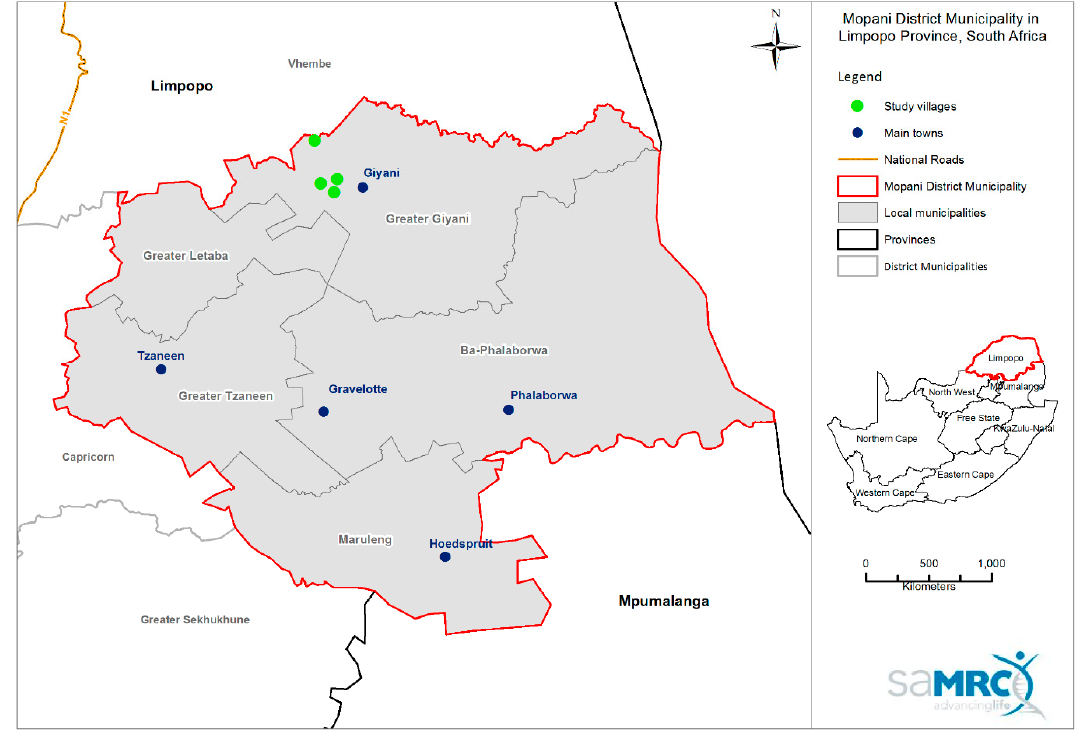
Figure 1. Map showing the study sites (green dots) in relation to Giyani town in Limpopo province, South Africa.